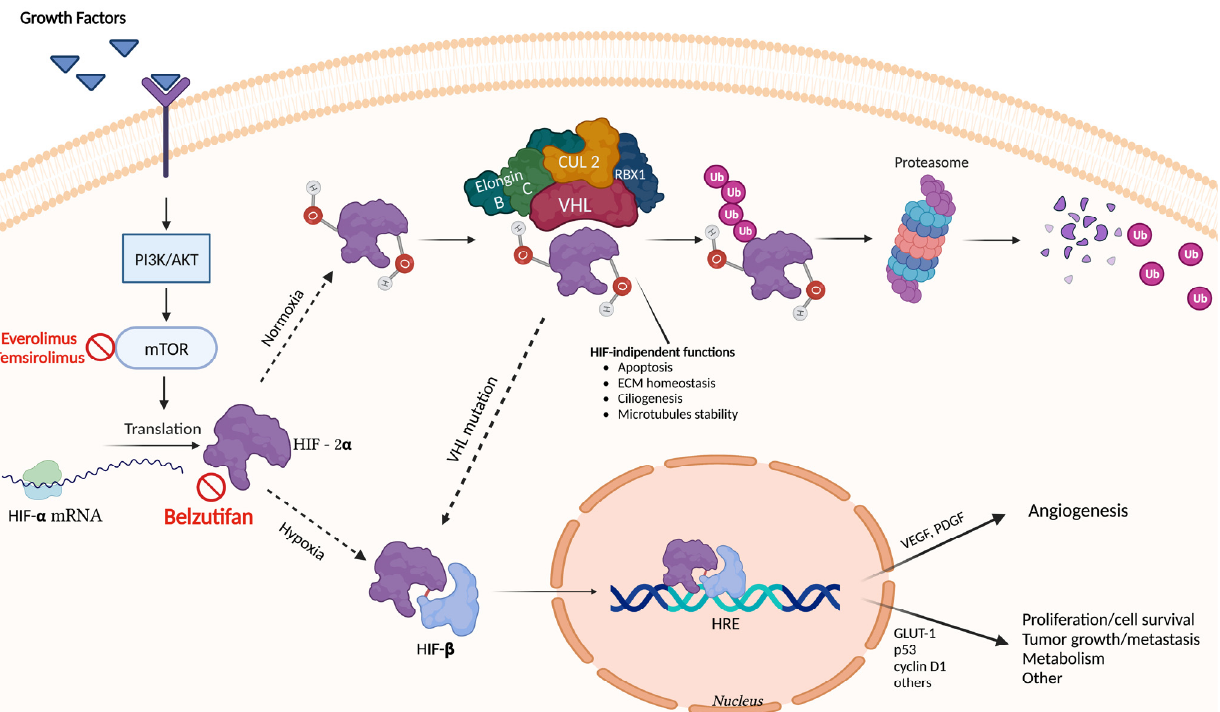
Figure 3. Overview of the HIF/pVHL mediated oxygen-sensing pathway and its therapeutic targets. In normoxic conditions, the hydroxylation of HIF-2 α creates a binding site for the pVHL-elongin BC complex, resulting in ubiquitination and subsequent proteasomal degradation of HIF-2 α . In hypoxic conditions, HIF-2 α is not hydroxylated, and pVHL cannot add destabilizing ubiquitin polymers to HIF-2 α that can then heterodimerize with HIF- β and translocate into the nucleus where it binds to HRE, resulting in activation of target genes. The cause of VHL syndrome is VHL PVs that lead to abnormal stabilization of HIF-2 α , eliciting a hypoxic response, thereby causing increased proliferation and tumorigenesis. The two major categories of drugs able to stop this pathway are the HIF inhibitors: indirect HIF inhibitors, such as mTOR inhibitors (everolimus and temsirolimus) that block HIF mRNA translation and therefore the formation of the functioning protein; direct HIF inhibitors, such as belzutifan, which inhibits the accumulation of HIF-2 α in the cells. Table 4. Typical VHL ‐ associated tumors and related frequency [158,159].